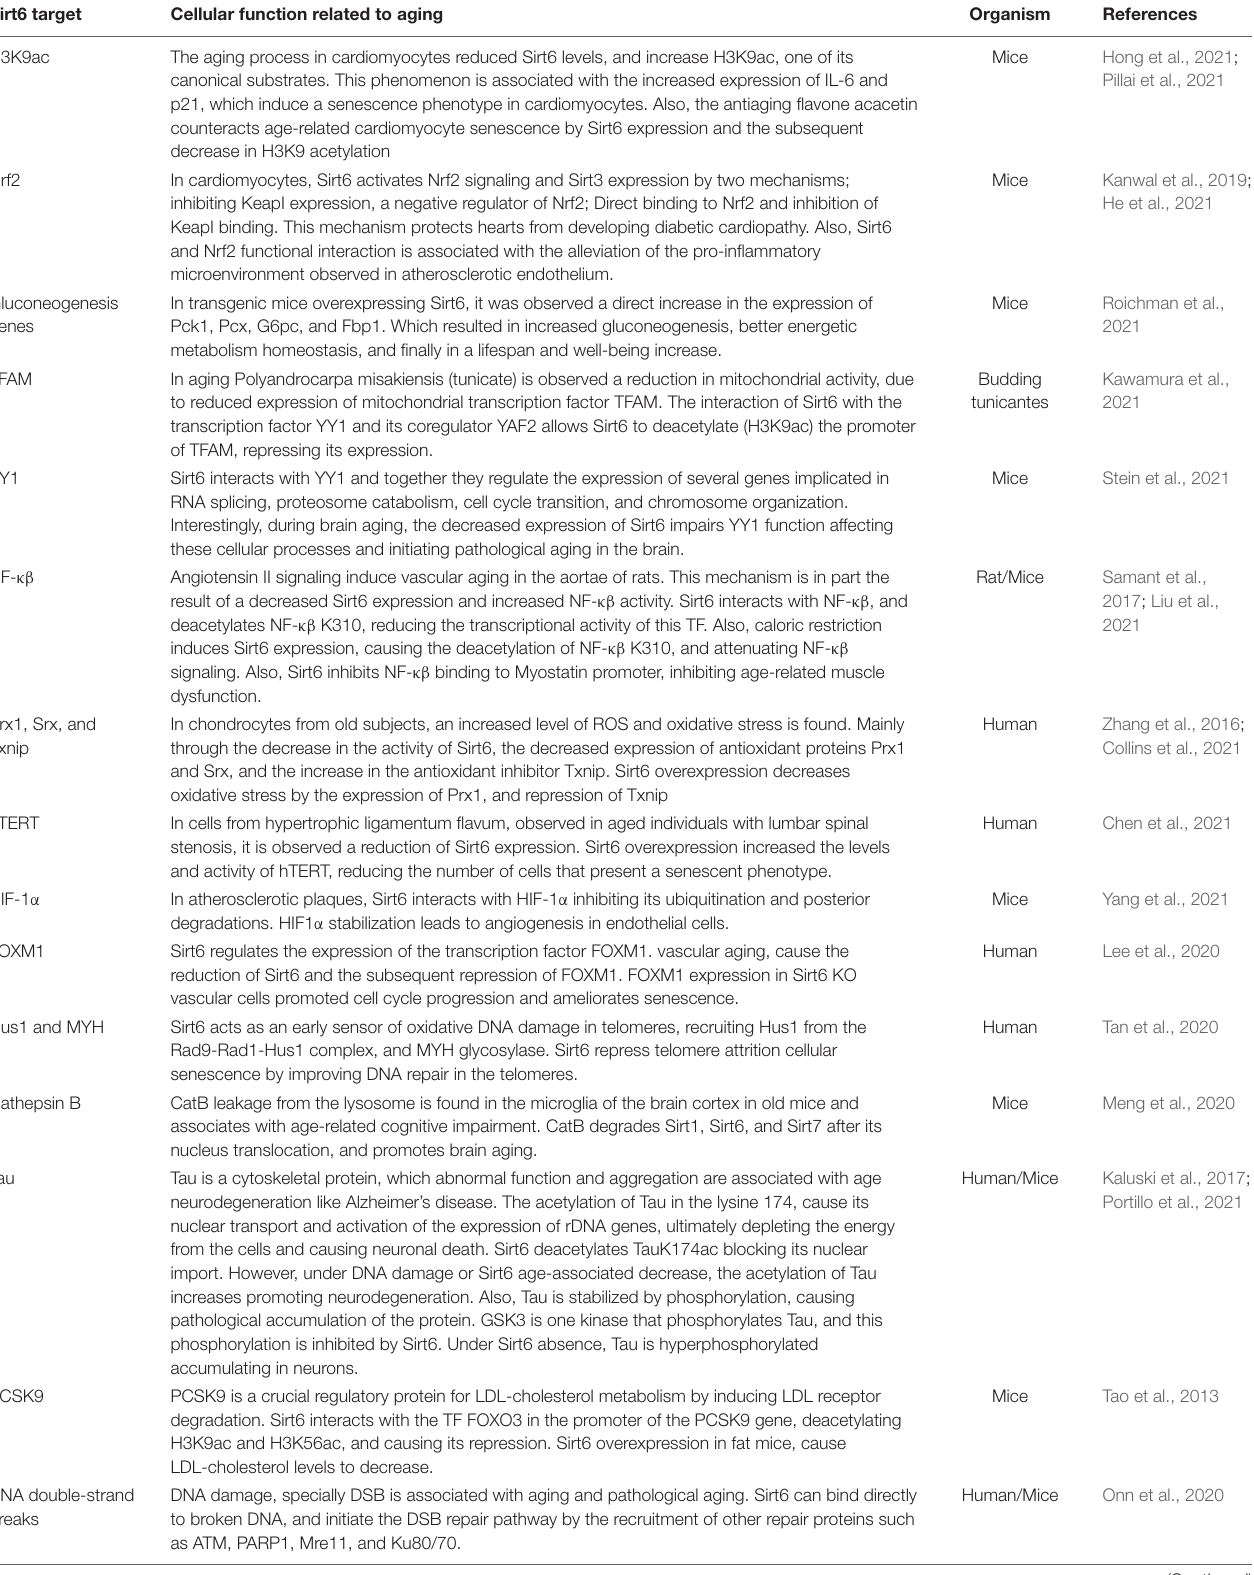
TABLE 1 | Sirt6 molecular targets associated with the aging